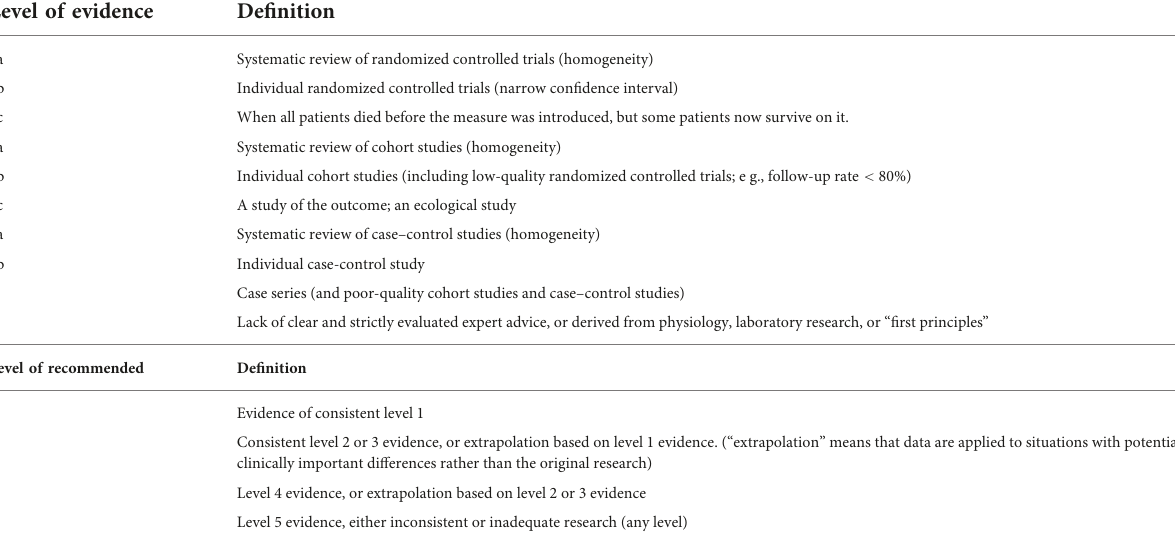
TABLE 1 Oxford University Center for Evidence-Based Medicine (OCEBM) evidence level and recommendation level standard. Level of